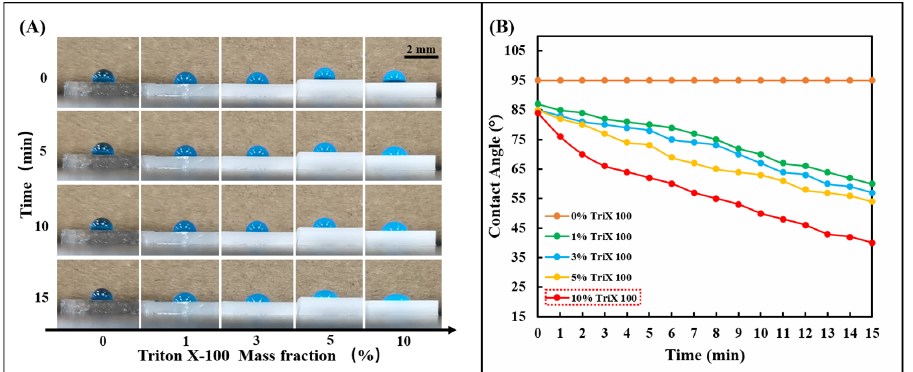
Figure 2. Hydrophilic treatment of PDMS with TritonX-100. ( A ) Change the mass percentage of Triton X-100 in PDMS (0, 1, 3, 5, 10%) and observe the change of the hydrophilic angle on the PDMS surface within 15 min. ( B ) The linear change rule of the hydrophilic angle on the surface of PDMS containing different concentrations of Triton X-100 (0, 1, 3, 5, 10%) within 15 min.